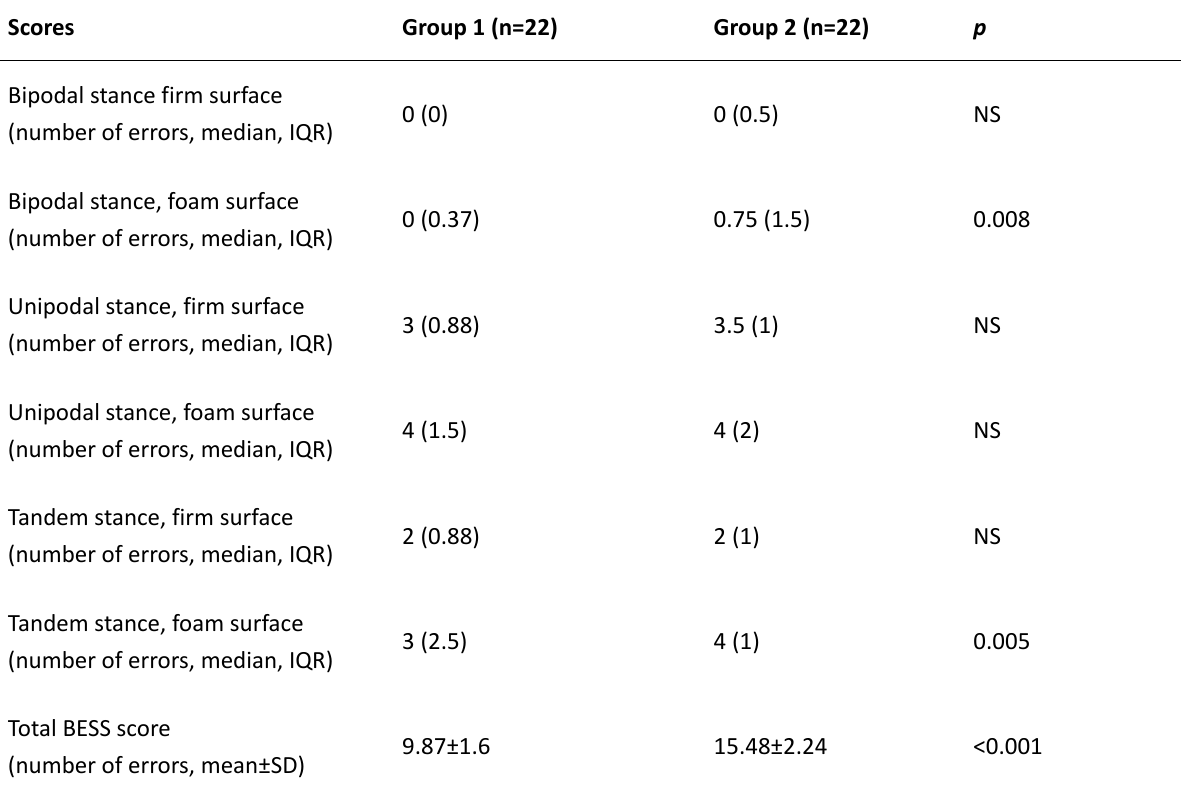
Table 1. BESS scores for both